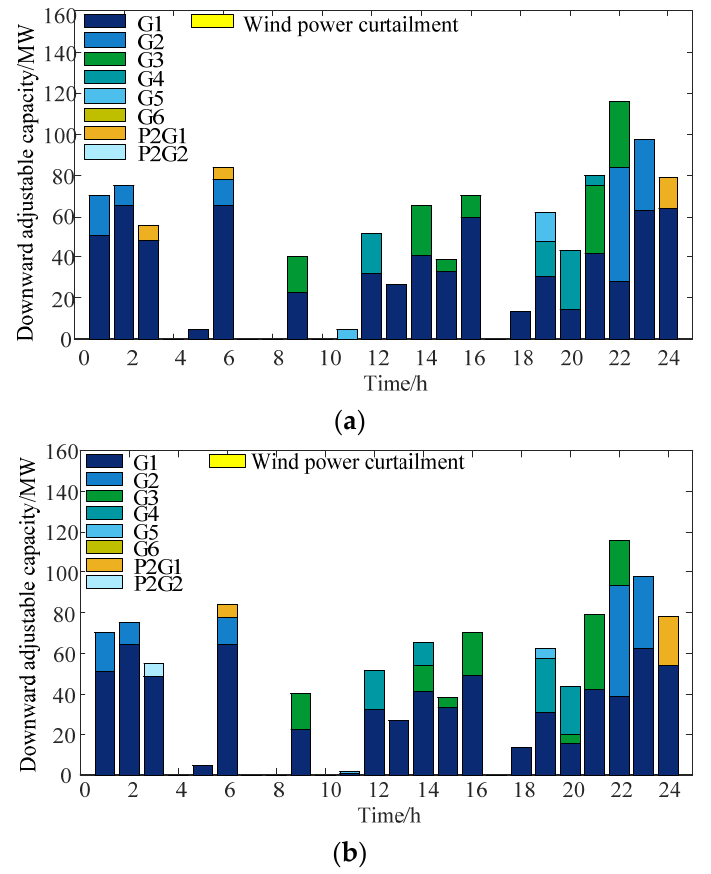
Figure 11. Power system downward adjustable capacity in different dispatch modes: ( a ) Separate optimization and ( b ) coordinated